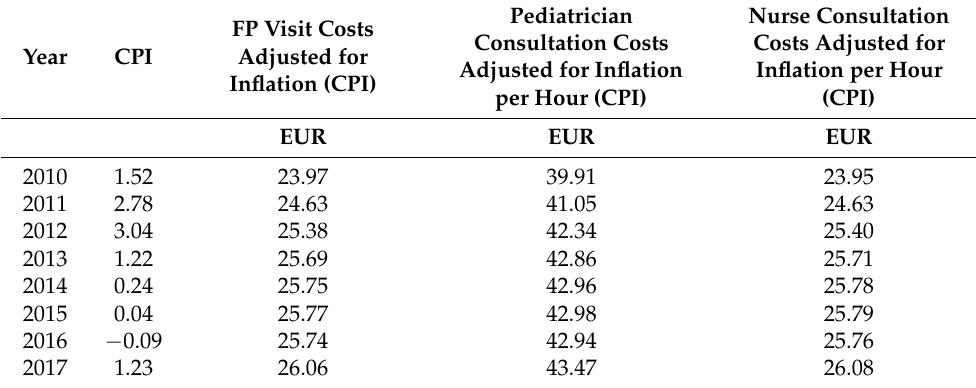
Table 1. Per visit costs for FP, pediatrician, and nurse consultation, adjusted for